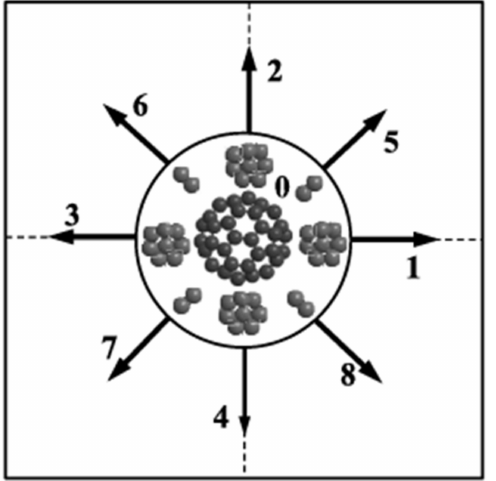
Figure 7. Discretization of space for the D2Q9 model (discrete velocity directions)